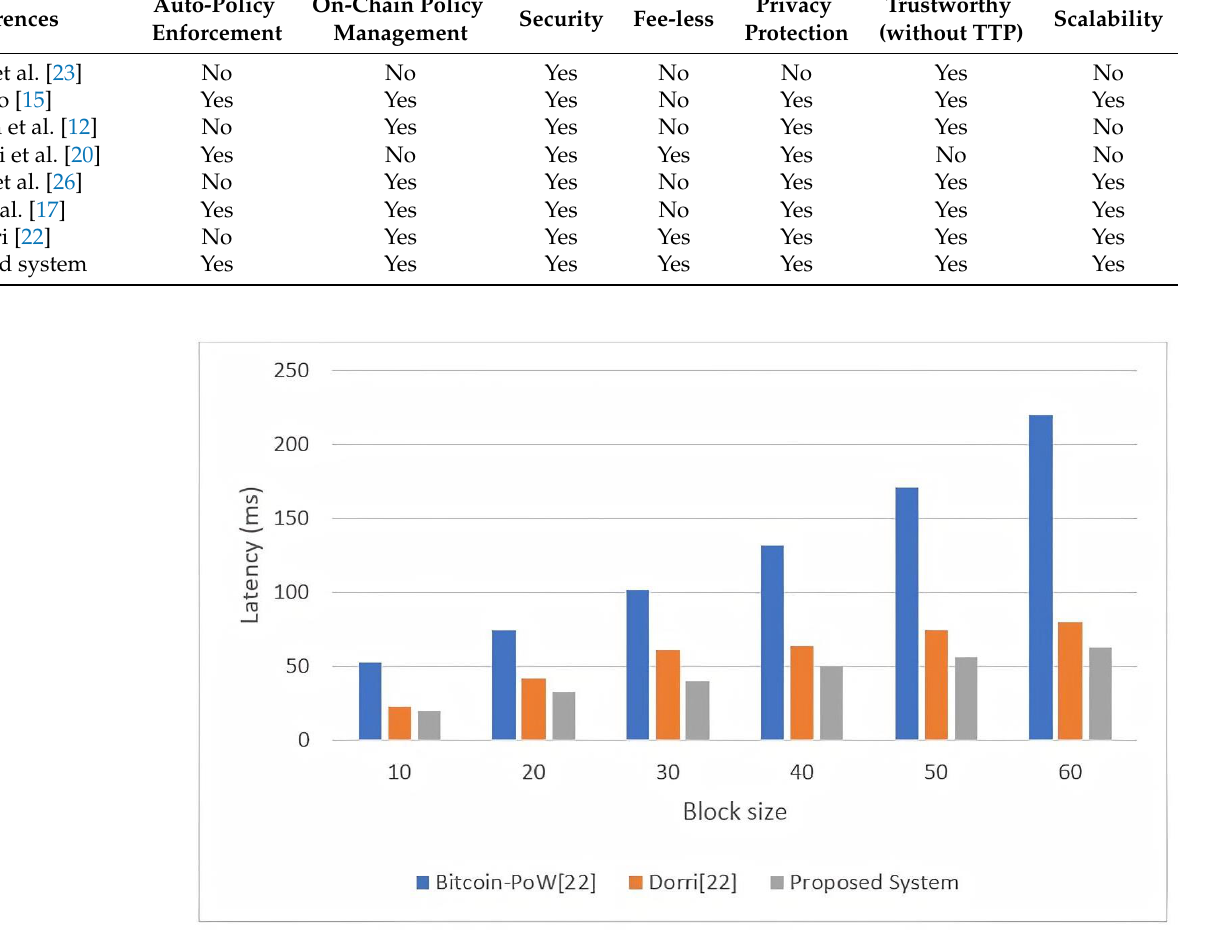
Figure 9. Processing overhead comparisons in the proposed